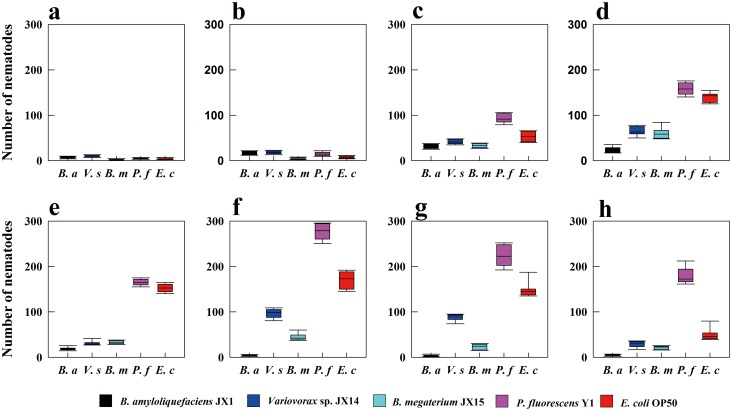
Variations in the number of C. elegans in the bacterial zone at different time points.Results are shown as box plots. a, b, c, d, e, f, g, and h represent 1, 2, 4, 8, 12, 24, 36, and 48 hours, respectively. B. a, V. s, B. m, P. f, E. c denotes B. amyloliquefaciens JX1, Variovorax sp. JX14, B. megaterium JX15, P. fluorescens Y1 and E. coli OP50, respectively (these abbreviations used in the following figures show the same meaning).